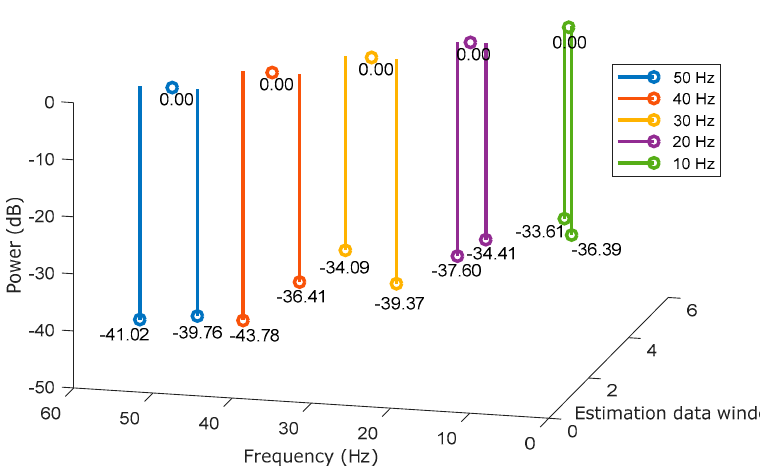
Figure 22. Prony estimated periodogram of VFD frequency speed operation scenarios.